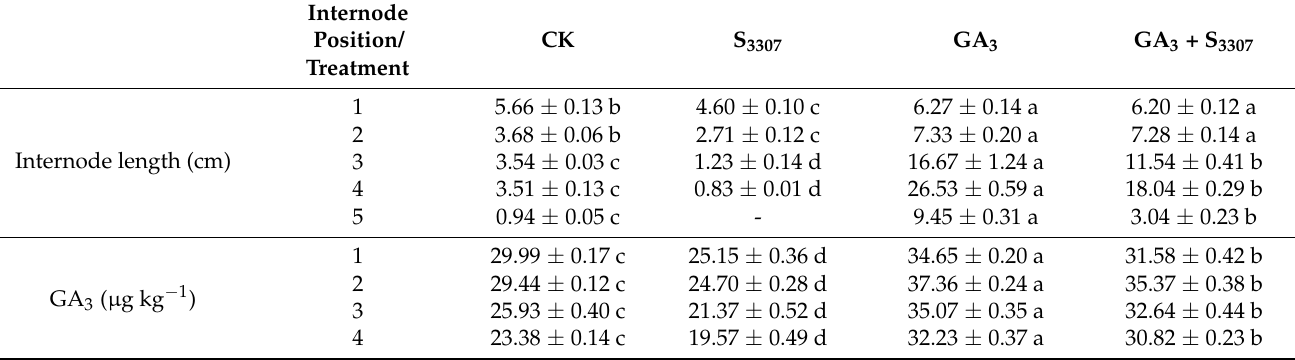
Table 4. Effects of GA 3 and uniconazole application on soybean internode length and stem GA 3.